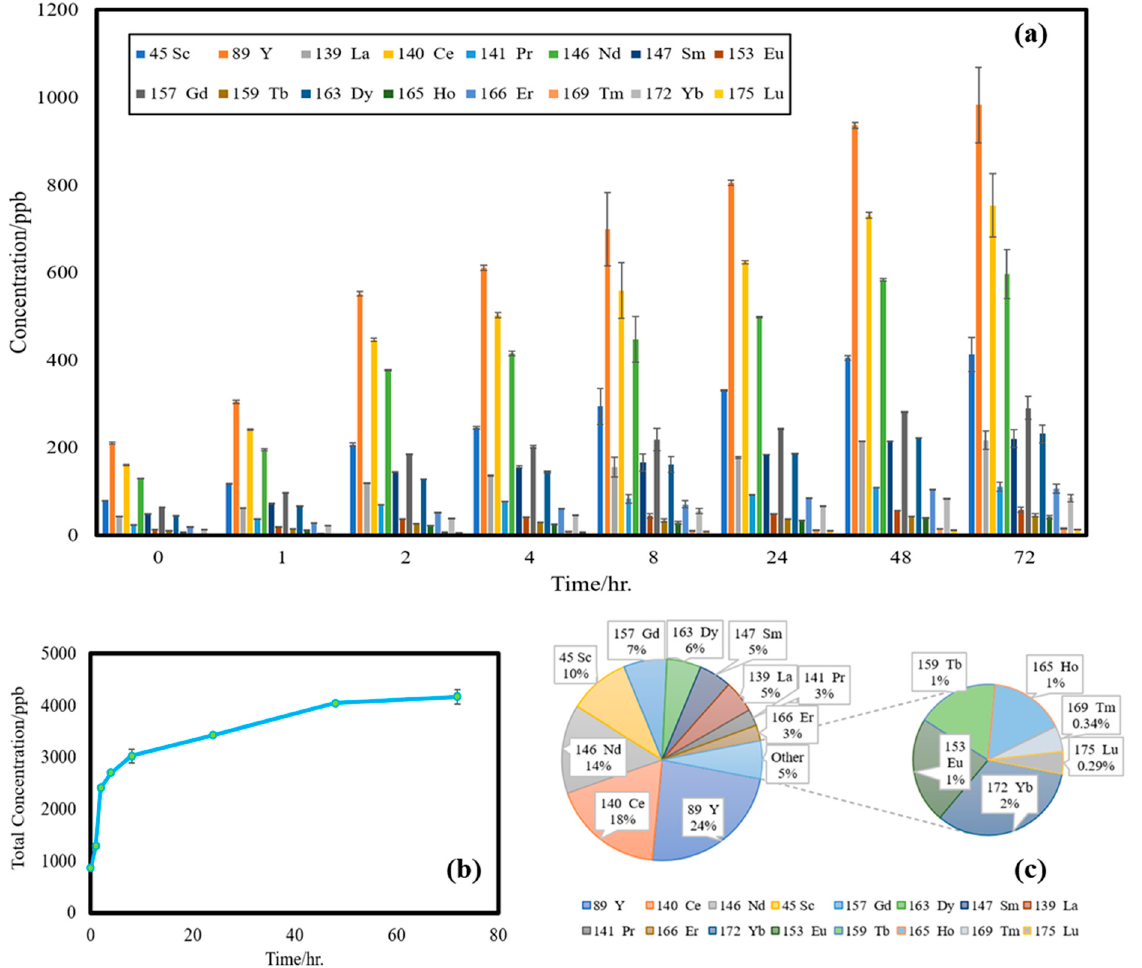
Figure 3. ( a ) Rare earth elements concentrations vs. leaching time of B4 test; ( b ) Total rare earth elements concentration vs. time in the leaching process of B4 test; ( c ) Percentage distribution of the REEs in the final leaching solution.